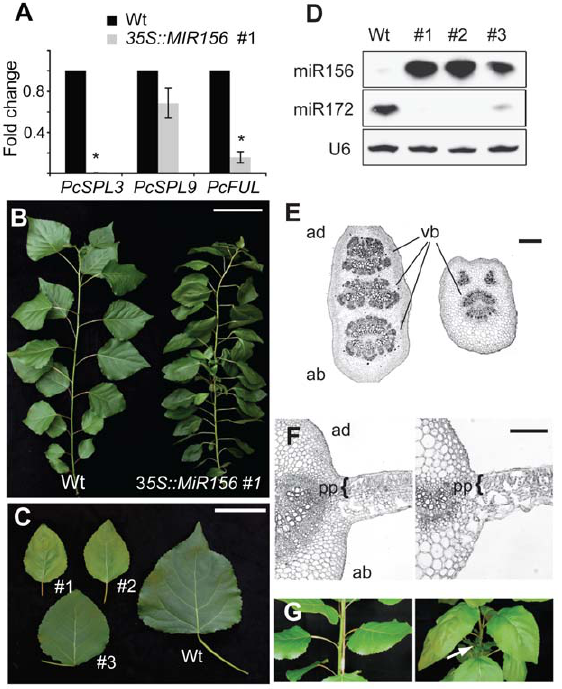
Figure 4. The phenotype of 35S::MIR156P.xcanadensis plants. (A) qRT-PCR analysis of the expression of PcSPL3 , PcSPL9 , and PcFUL in 6-month-old plants, normalized to PcACT . Wild-type expression levels were normalized to 1. Asterix=significantly different from wild type, p , 0.01, Student’s t test. (B) Single branch from 6-month-old wild-type (WT) and 35S::MIR156 ( # 1) plants. Scale bar indicates 10 cm. (C) Leaves of 6-month-old wild-type and three independent 35S::MIR156 trans- genic lines ( # 1 to # 3). Scale bar indicates 5 cm. (D) Expression of miR156 and miR172. (E) Petiole sections of wild-type (left) and 35S::MIR156 ( # 1) (right). Scale bar indicates 200 m m. (F) Transverse sections of a major vein and the lamina of 6-month-old fully expanded leaves from wild-type (left) and 35S::MIR156 ( # 1) (right) plants. pp=palisade parenchyma. Scale bars indicate 50 m m. (G) Primary shoots of 2-month-old wild-type (left) and 35S::MIR156 ( # 1) (right) plants. Arrows indicate lateral shoots. Scale bars indicate 5 cm.